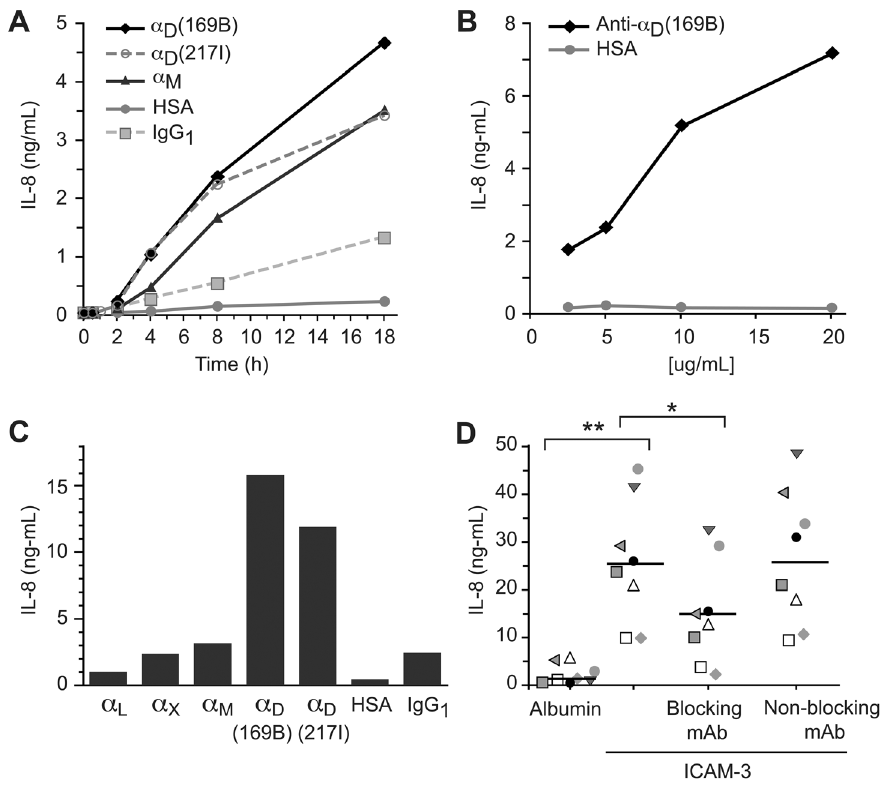
Figure 5. Engagement of integrin a D b 2 induces expression and release of IL-8 by human monocytes. Unfractionated human monocytes were incubated in wells coated with immobilized mAb against a D , or in wells coated with HSA or IgG1 as control conditions, for various times. Supernatants were collected and analyzed for IL-8 by ELISA. In some experiments engagement of a D b 2 was compared to engagement of other leukocyte integrins using immobilized mAb against individual leukocyte integrin a subunits. A. Engagement of a D b 2 by immobilized anti- a D mAb induced time-dependent release of IL-8, whereas IL-8 secretion by monocytes incubated on HSA- or IgG1-coated control surfaces was much lower. In parallel, incubation of monocytes with LPS (100 m g/ml) in suspension induced release of IL-8 at 8 (1.1 ng/ml) and 18 hr (4.4 ng/ml) (not shown). Engagement of a M b 2 also induced time-dependent release of IL-8. B. Release of IL-8 triggered by engagement of a D b 2 on monocytes was dependent on the concentration of anti- a D mAb used to coat the wells. This figure indicates the results from an 8 hr incubation of monocytes on the triggering and control surfaces. C. Engagement of integrin a D b 2 was a potent stimulus for IL-8 secretion at 8 hr when immobilized mAb against a D were compared to immobilized mAb against other leukocyte integrin a subunits. Two activating anti- a D monoclonal antibodies, 169B and 217I, were examined in this experiment. The data in Panels A-C are individual determinations in single experiments. Data from additional experiments done at the 8 hr time point using monocytes from multiple different donors are shown in Tables S3 and S4. D. Wells were coated with human albumin or recombinant ICAM-3, monocytes were incubated in these wells for 18 hr. alone, in the presence of a blocking anti- a D mAb (mAb 240I), or in the presence of a non-blocking anti- a D monoclonal antibody (mAb 169A). IL-8 was then measured in the supernatants. The figure indicates the results of incubations with monocytes from 8 different subjects studied in 5 separate experiments on different days. Results from each subject are identified by a different symbol. The horizontal bars in the columns of data points indicate the means of determinations for each condition. The data were analyzed with Tukey’s multiple comparison test and the Neuman-Kuels multiple comparison test, with similar results in each case. The significance values from the Neuman-Kuels analysis are shown (** 5 p , 0.001; * 5 p , 0.01). There was no difference in release of the IL-8 when monocytes were incubated with ICAM-3 alone versus incubation with ICAM-3 in the presence of the non-blocking mAb (p .